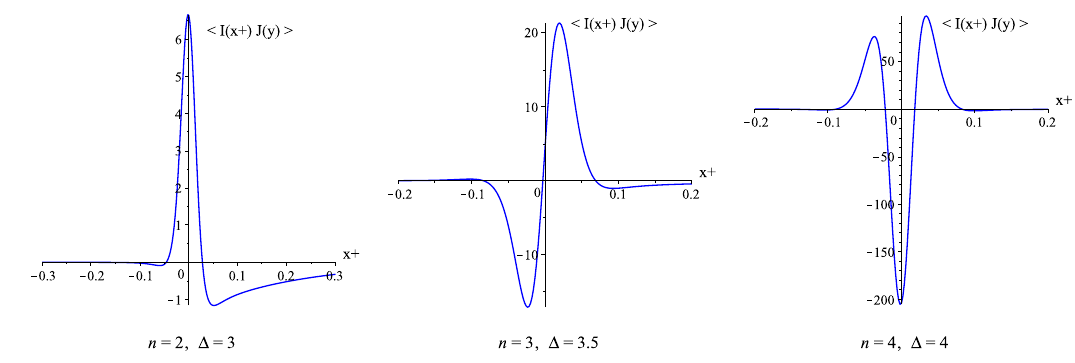
Figure 2 . The imaginary part of h I ( x + ) J ( n ) ( y ) i , defined in (5.15), as a function of x + for various values of n and ∆ . Left panel: n = 2 , ∆ = 3 , δ = 0 . 03 . Middle panel: n = 3 , ∆ = 3 . 5 , δ = 0 . 05 . Right panel: n = 4 , ∆ = 4 , δ = 0 . 05 . In all plots y + = − 1 . 5 , y − = 1 . 2 and θ = 0